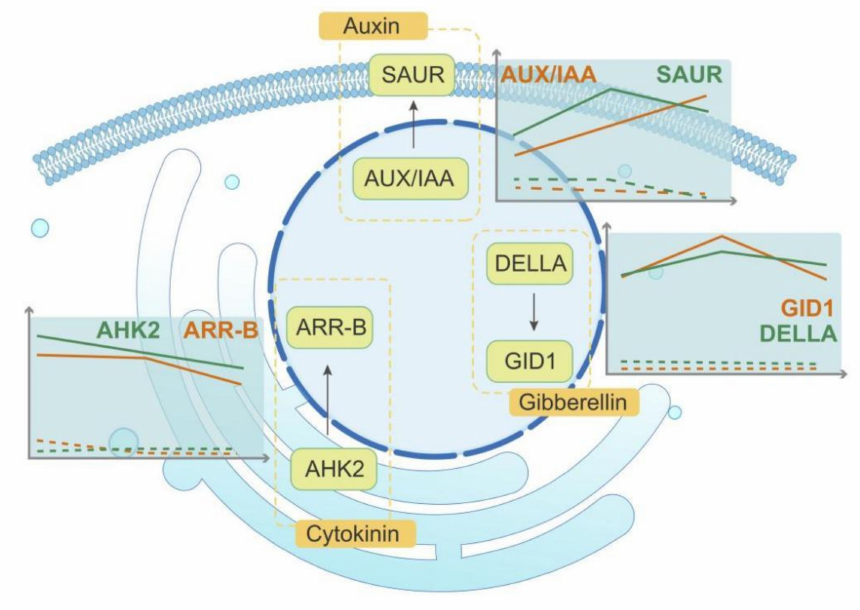
Figure 7. Speculative network model revealing the ovule abortion in the female sterile line of Pinus tabuliformis